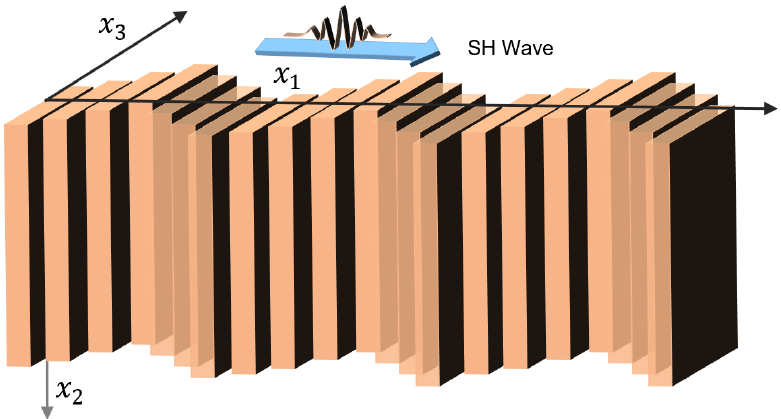
Figure 4. Schematic of the shear horizontal (SH) waves propagating through a substrate [91].